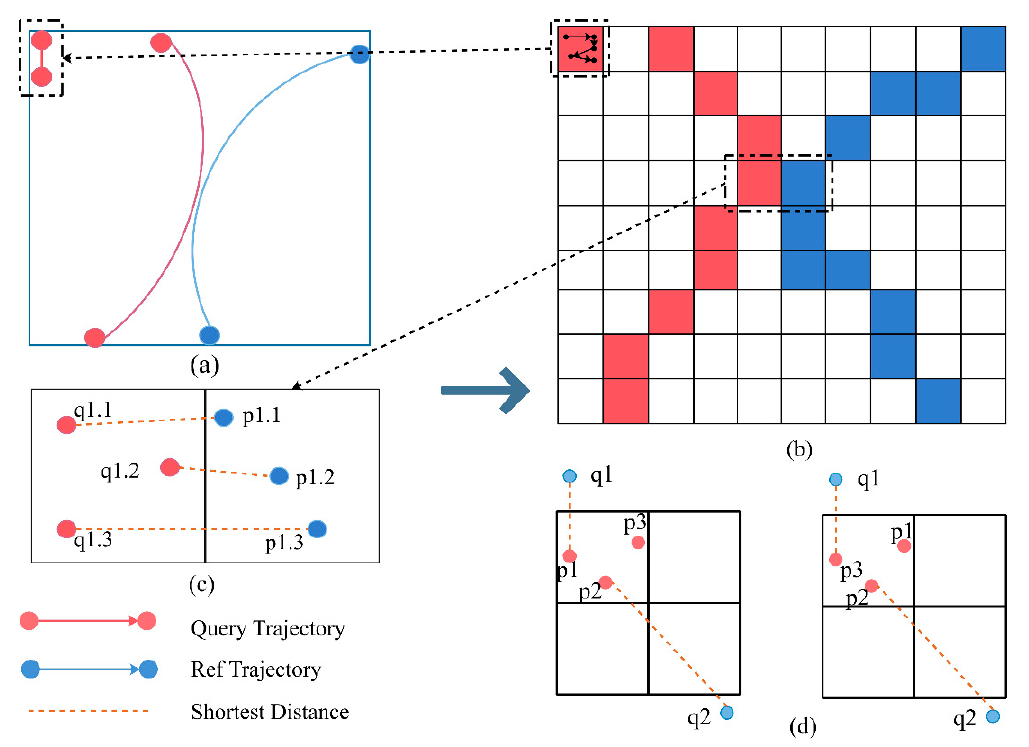
Figure 5. An example of the grid-based search method. ( a ) Original query and reference trajectories; ( b ) rasterized trajectory data; ( c ) distribution of query and reference points within grids and the matched point connection; ( d ) matched point connection when the order constraint is enforced.